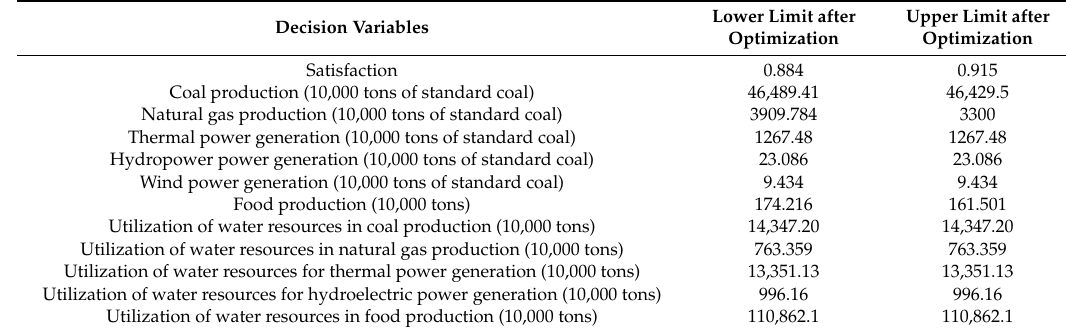
Table 2. Ordos WEF system security satisfaction and decision variable